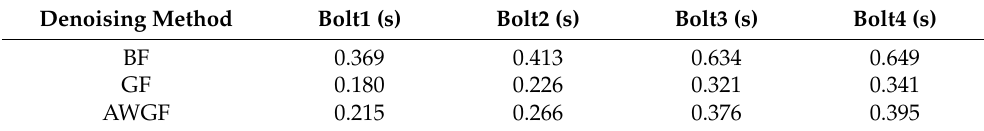
Table 3. Smoothing time